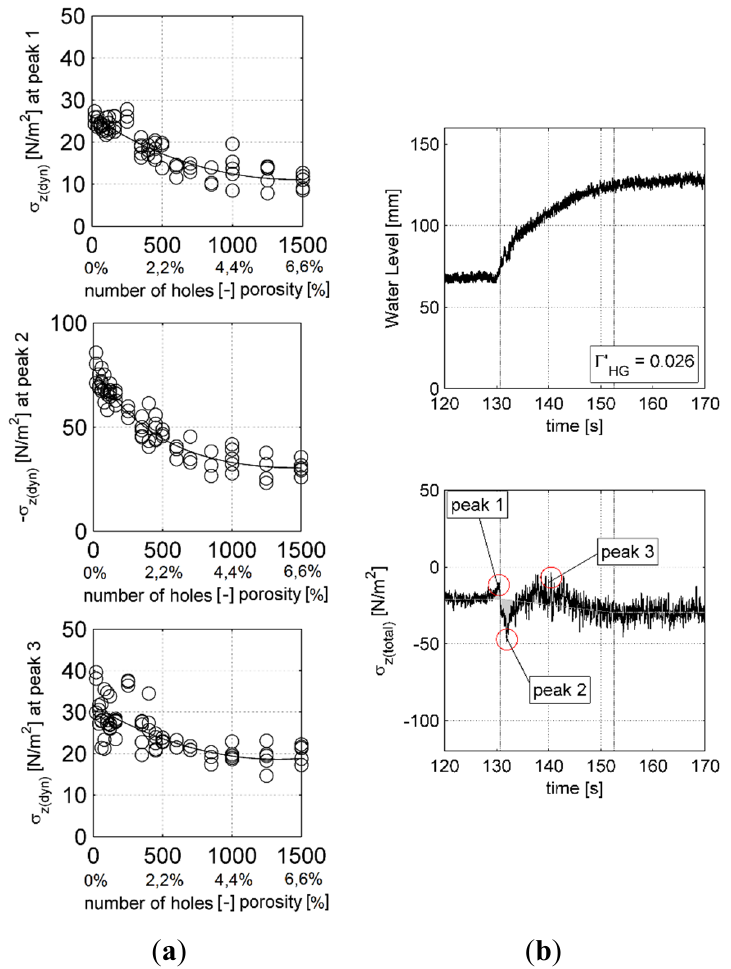
Figure 10. Experiments over a modified, porous streambed with a constant hydrograph: = 67 mm, (cid:1856) = 132 mm, ∆(cid:1843) = 28.6 L/s, ∆(cid:1872) = 21.8 L/s 2 , (cid:1985) (cid:3009)(cid:3008)(cid:4593) = 0.026. (cid:1856) (cid:3036)(cid:3041)(cid:3036)(cid:3047)(cid:3036)(cid:3028)(cid:3039) (cid:3040)(cid:3028)(cid:3051) (cid:3019) ( a) Dynamic lift for each peak, plotted with trend lines over the number of holes drilled into the artificial streambed (hole diameter: 3 mm). Streambed porosity in % according to Equation (4); ( b) Water level above roughness tops and total measured lift force over time during flow increase with a modified, highly porous bed (1500